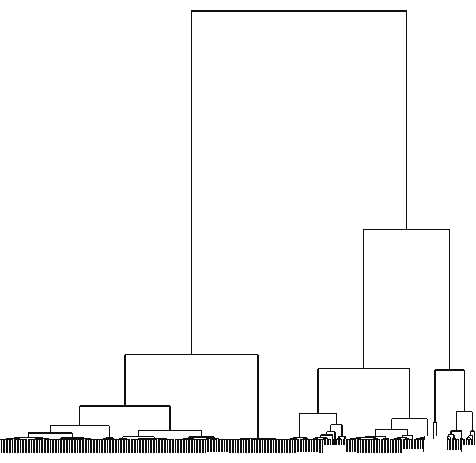
Figure 1: Dendrogram obtained by applying the multinomial specification of the clustering